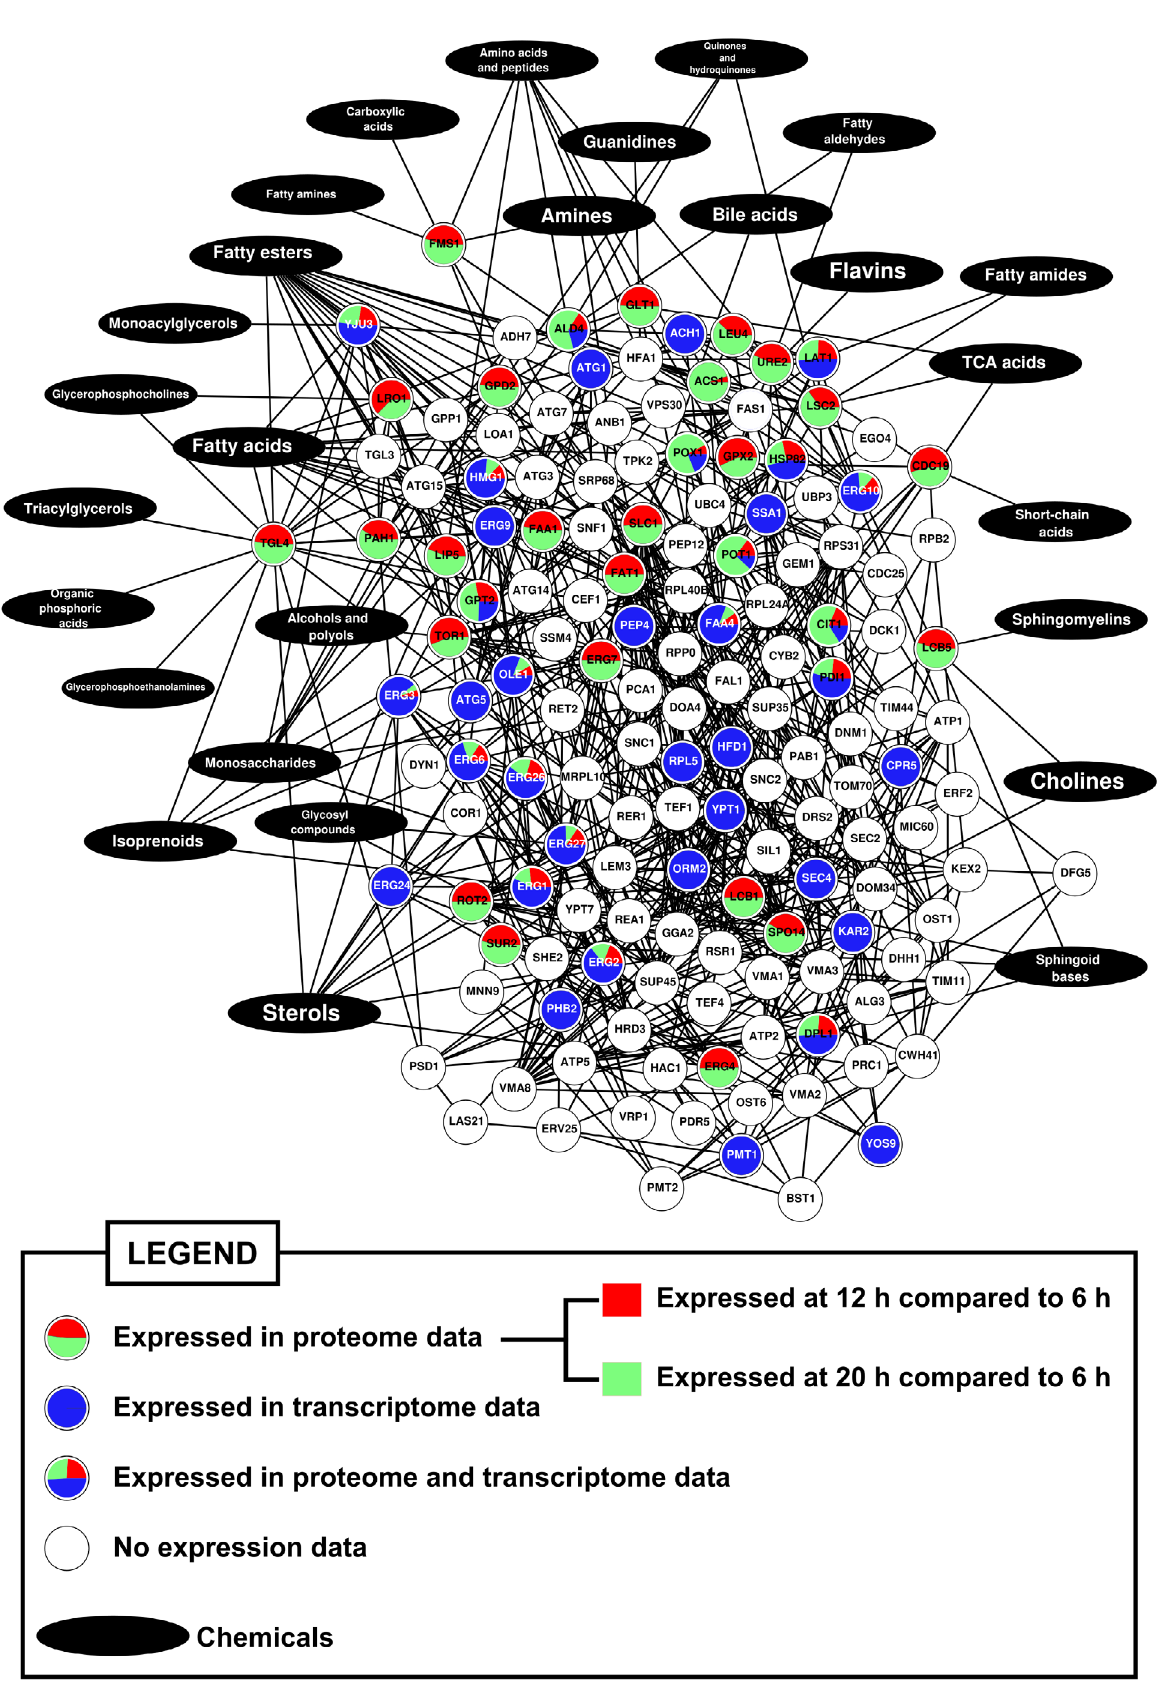
Figure 5 - Shortest-pathway chemical-protein interaction (CPI) network of lipid droplets-associated proteins and molecules linked to lipid metabolism (LDP network). Expression data from proteome (Casanovas et al ., 2015) and transcriptome (this study) analyses were added to network and are indicated as pie charts inside the nodes in different colors. Each pie slice is proportional to proteome and/or transcriptome expression values for a given